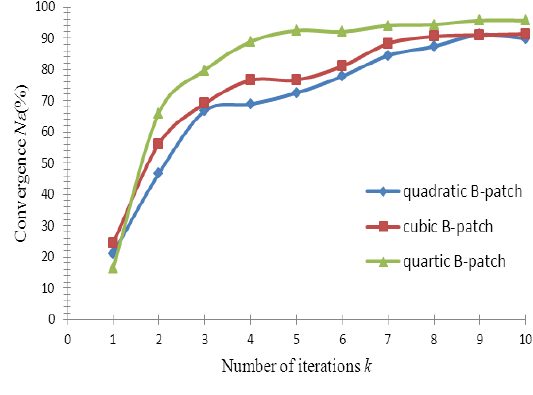
Figure 8. Convergence are proportional to the number of iteration k